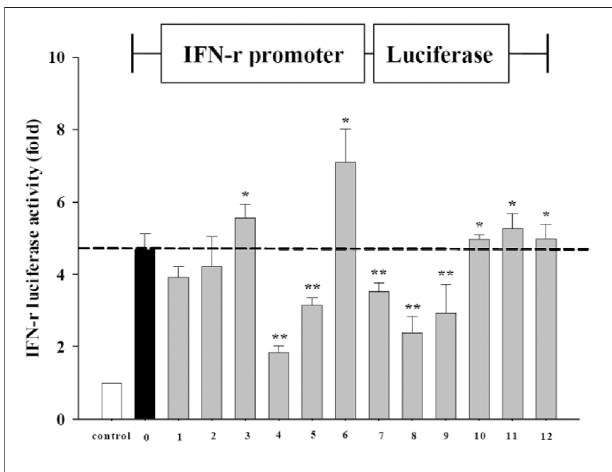
FIGURE 4 | IFN γ -luciferase activity compounds 1 ∼ 12 from AP EtOAc extract. EL-4 T cells transfected with IFN γ -luciferase reporter gene were stimulated with PMA (50 ng/ml)/ionomycin (1,000 ng/ml) in the absence or presence of 12 test compounds. Data representative of three independent experiments are expressed as mean ± SD. IFN γ -luciferase activity is represented as a fold ratio to the control without stimulation (white bar). * p < 0.05; **, p < 0.01 vs. stimulated cells in the absence of test compound (black bar). AP, Andrographis paniculata ; EtOAc, ethyl acetate; PMA, phorbol 12-myristate